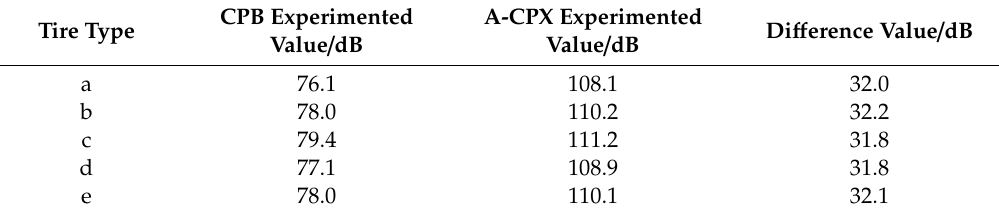
Table 3. Comparison of tire noise between CPB and A-CPX methods.